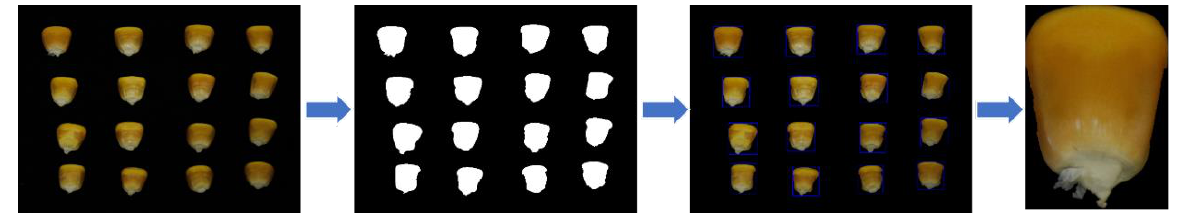
2.2. Image Processing